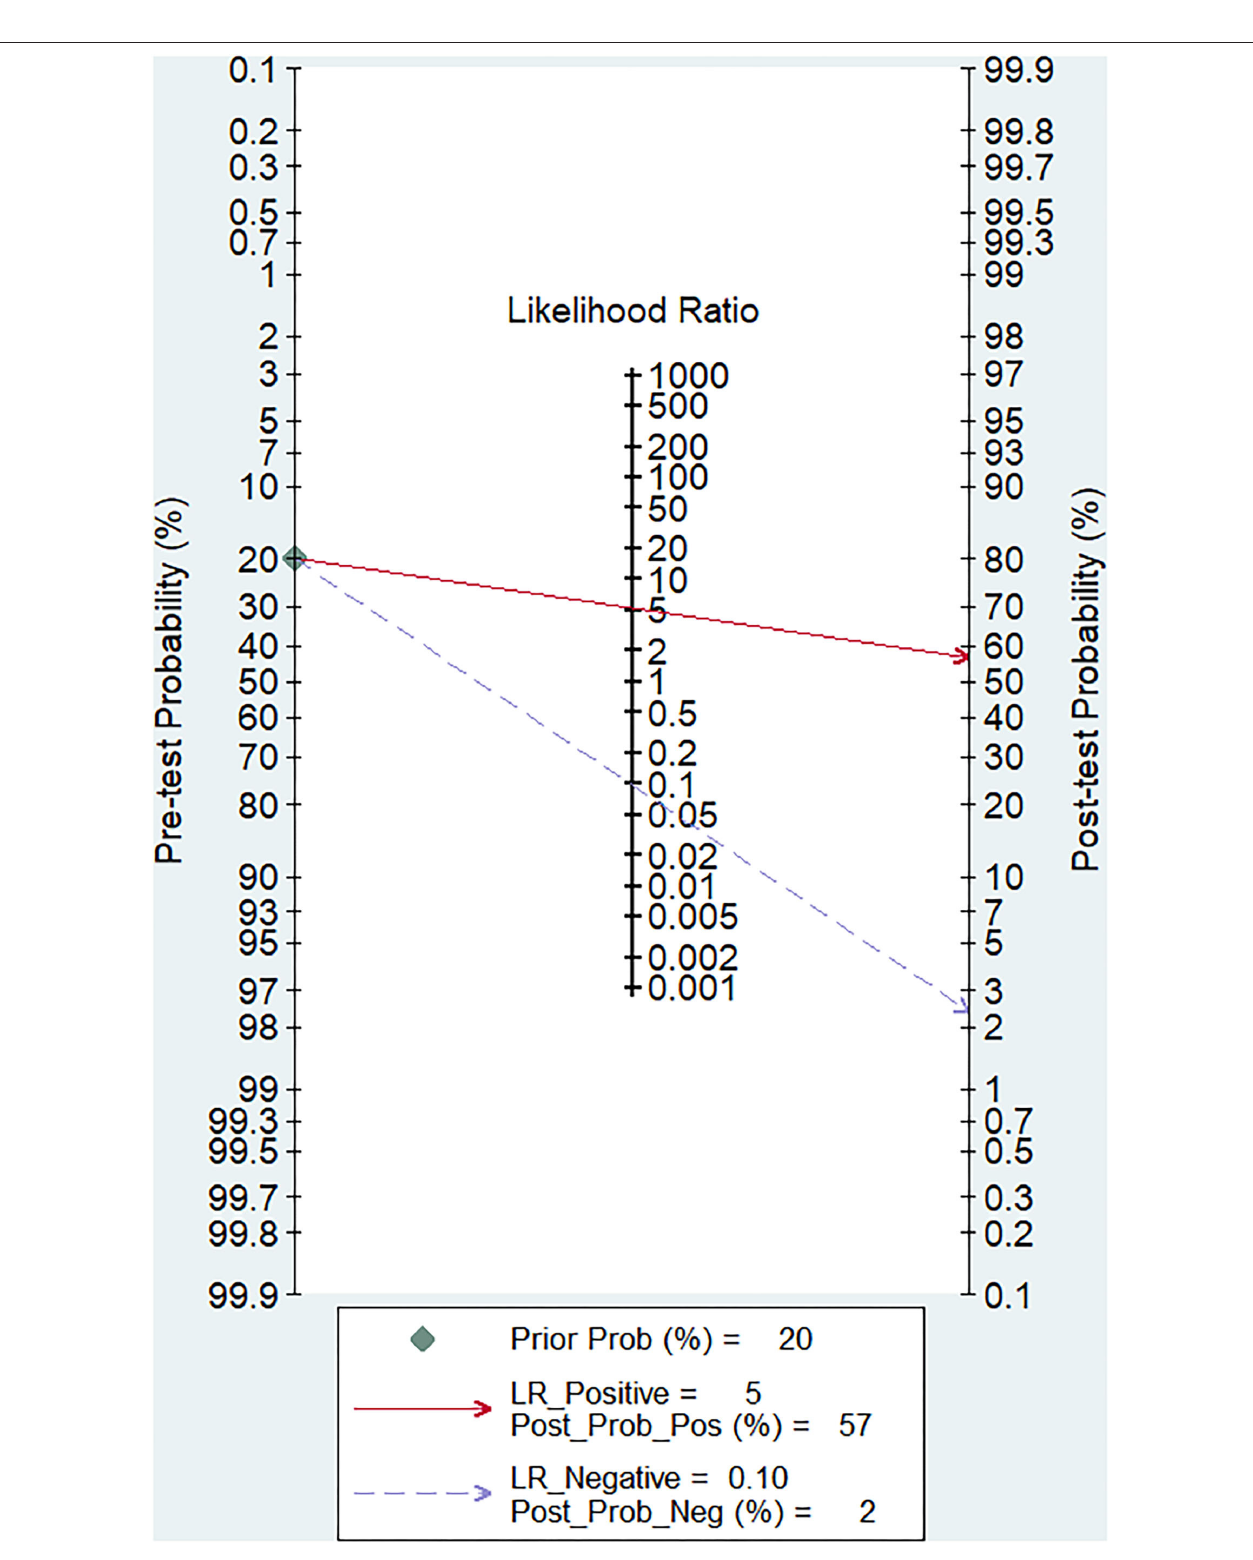
FIGURE 5 | Fagan’s Nomogram for assessment of post-test probabilities.